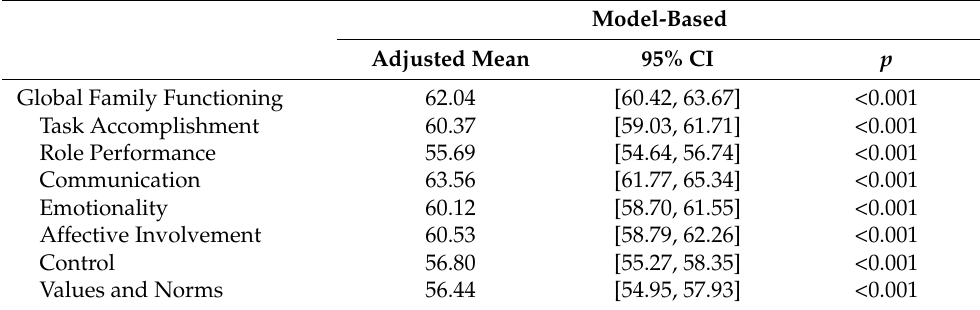
Table 3. Overall family members’ ratings of family functioning (FAM) compared to normative data.